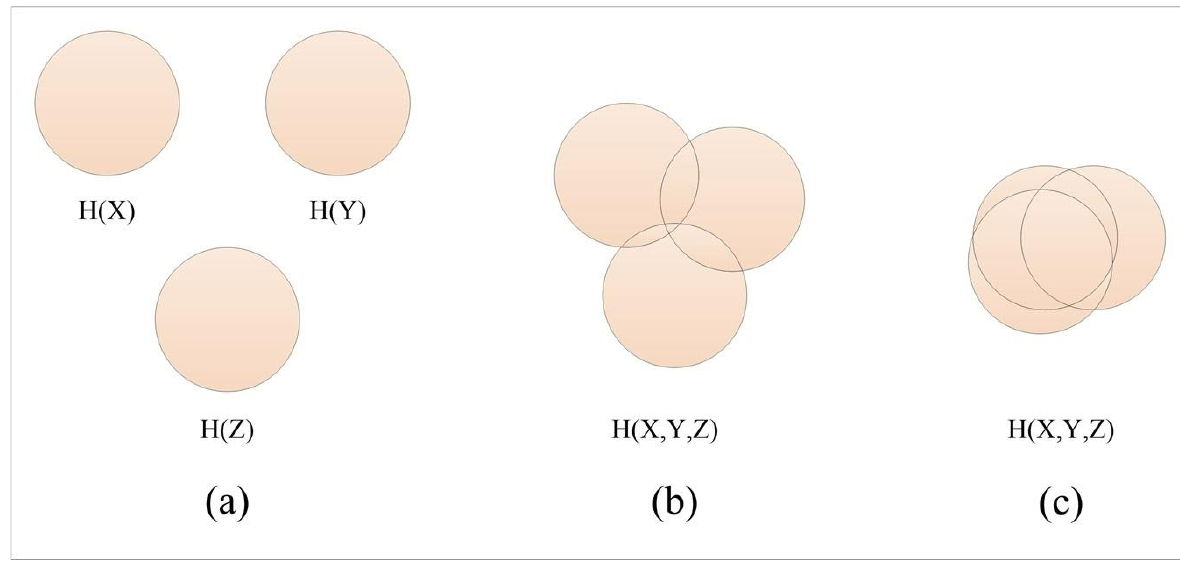
Figure 2. Schematic diagrams of information entropy of rain gauge stations and joint information entropy: ( a ) Information entropy of rain gauge stations X, Y, and Z; ( b ) Joint information entropy between the three stations when the degree of redundancy is low; ( c ) Joint information entropy between the three stations when the degree of redundancy is high.